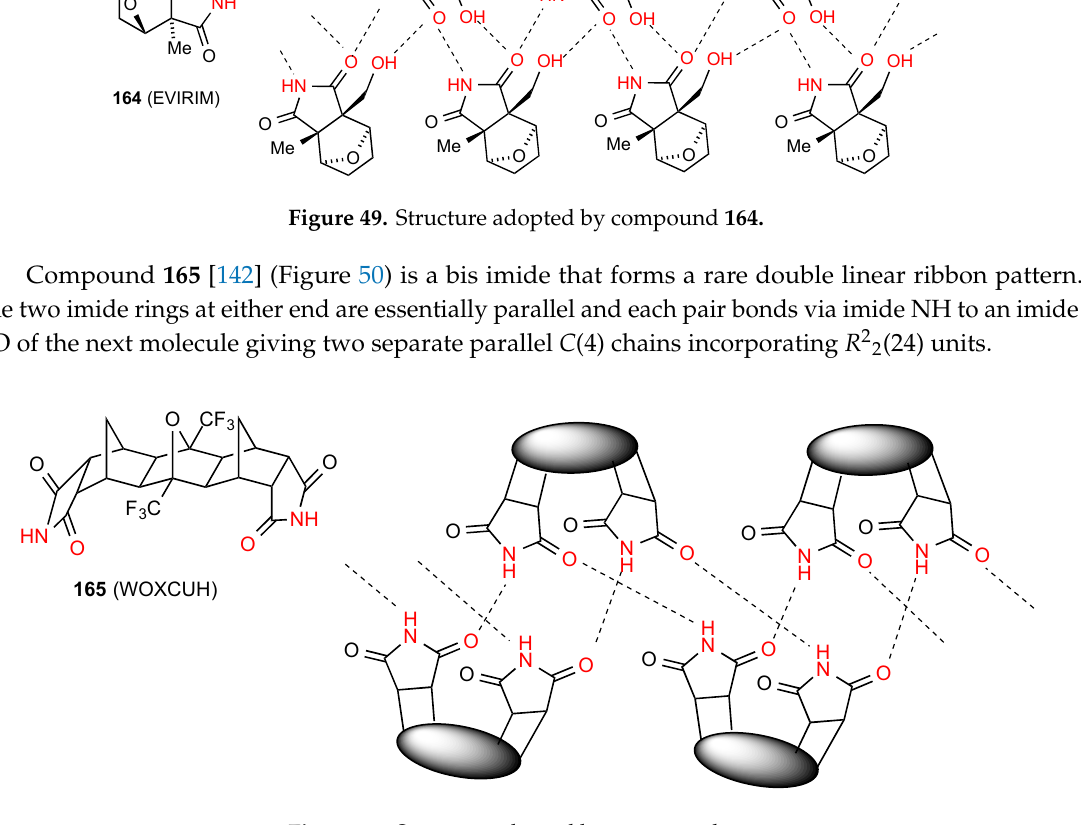
Figure 48. Structure adopted by compound 163.